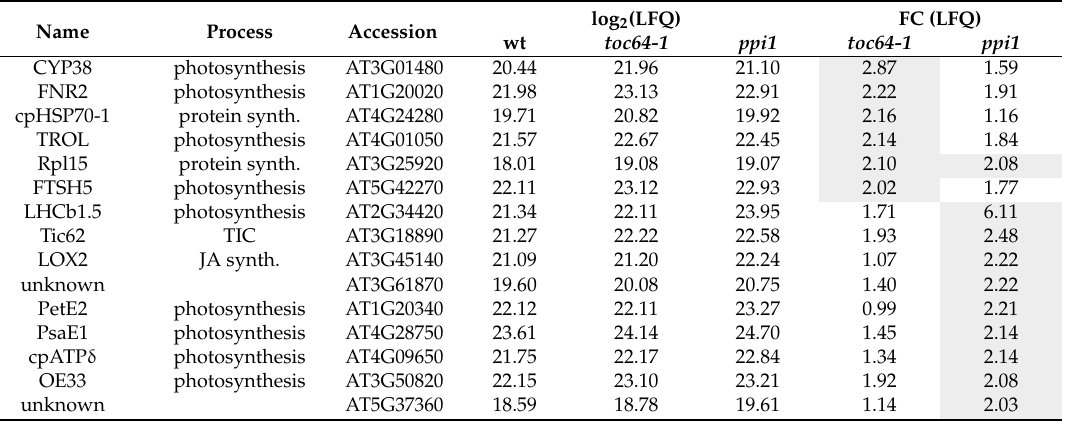
Table 1. Proteins predicted to be plastidic localized and exhibiting lower or higher abundance in chloroplasts isolated from mutants in comparison to wild-type chloroplasts. The protein name, the process the protein is acting in, the accession number and the obtained label-free quantification (LFQ) values (log 2 ) are shown. The fold change (FC) according to the LFQ values, is presented for toc64-1 and ppi1 in comparison to the wild type; fold-change values > 2 or < 2 are marked in green or red,